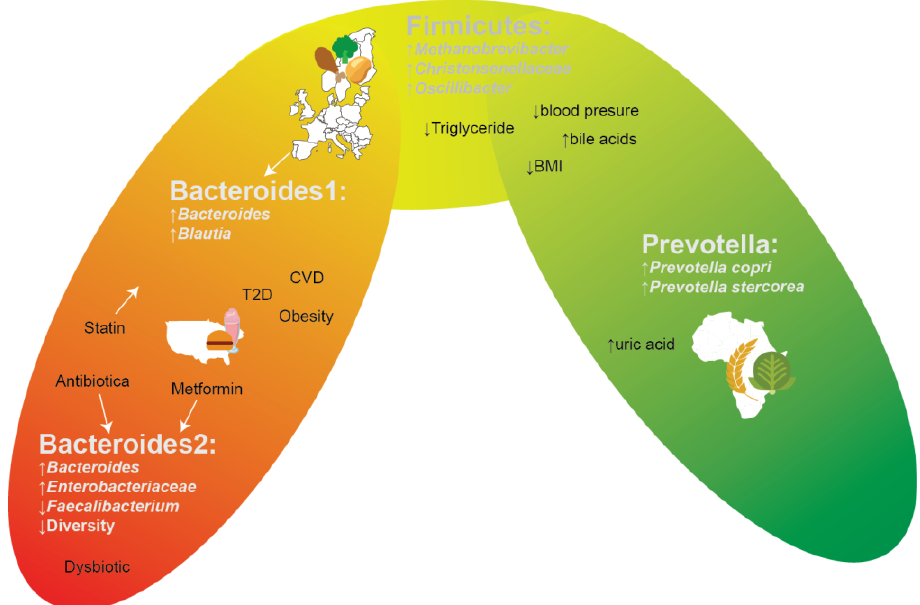
Figure 1. Gradient-like depiction of enterotypes and their corresponding associations.